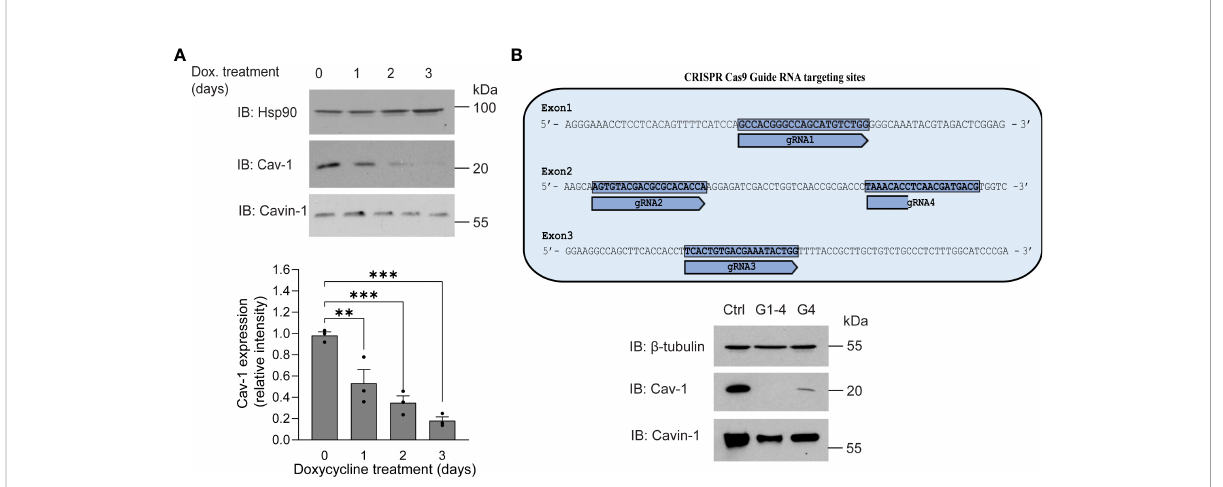
FIGURE 3 Generation of caveolin-1 knock-out HULEC5 a cells by CRISPR-Cas9 lentiviral system mediated gene editing. (A) HULEC5 a cells were simultaneously transduced by lentiviruses encoding four different guide RNAs (G1-4) targeting exons 1-4 of Cav-1. After 6 hours, cells were treated for four days with 1 µg/mL doxycycline to induce Cas9 and loss of caveolin-1 through genome editing. After administration of